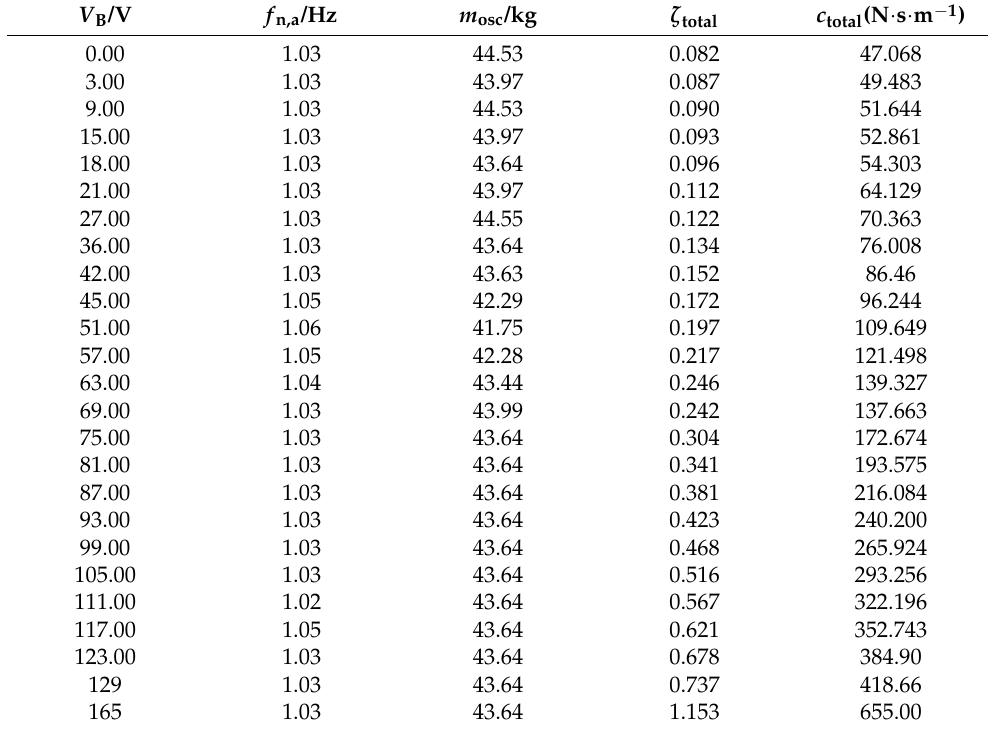
Table 3. Results of free decay tests in the air ( D = 0.06 m).